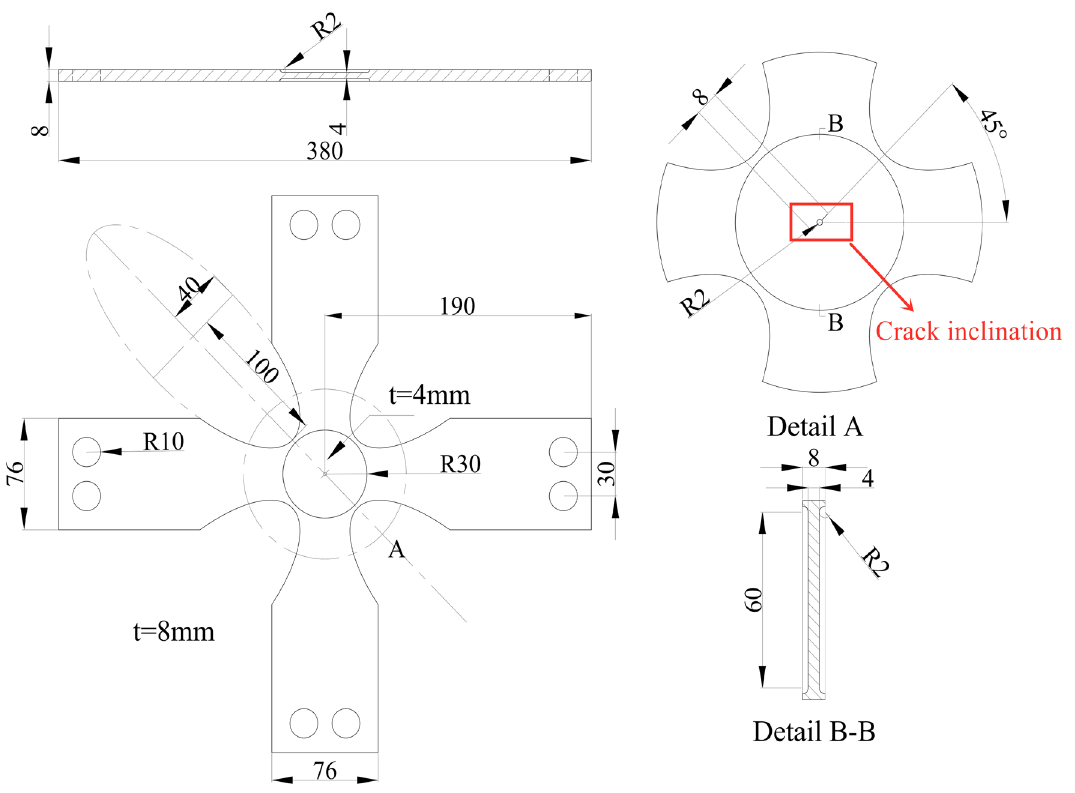
Fig. 1 Schematic of the cruciform specimen with inclined crack